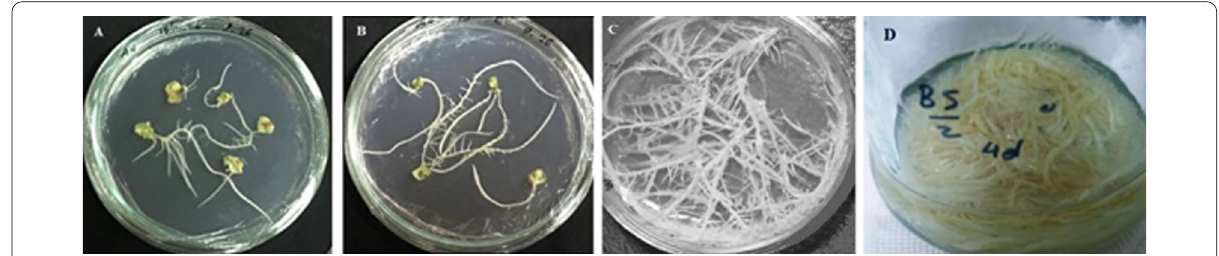
Fig. 1 Hairy roots obtained from leaf explants ( a ) and cotyledons ( b ) inoculated for 15 min with the R. rhizogenes strain A4, 3‑week‑old roots obtained from inoculation of cotyledon explants with the strain R. rhizogenes A4 ( c ). HR‑G3 line of hairy root in liquid 1/2 B5 culture medium ( d )